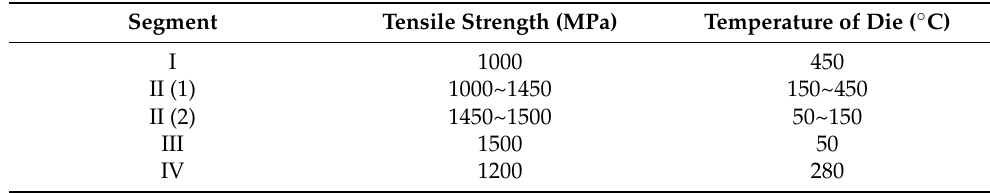
Figure 15. Fitted relationships of ( a ) hardness and tensile strength, and ( b ) hardness and elongation at break. Table 5. Simulation scheme of